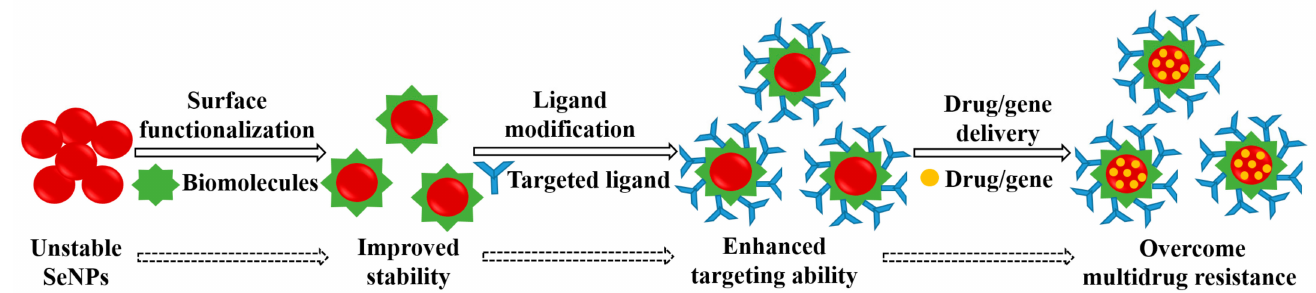
Figure 1. Illustrations of emphasized details in this